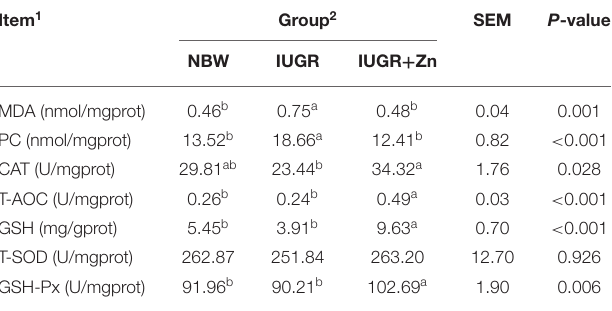
TABLE 5 | Effects of dietary Nano-ZnO supplementation on the antioxidant status of jejunal mucosa of the IUGR finishing pigs. Item 1